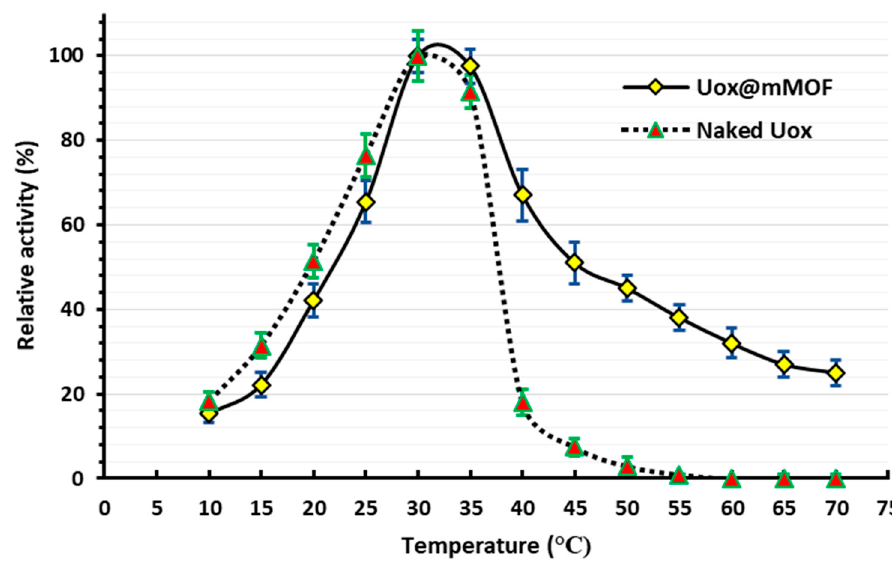
Figure 6. The optimum temperature of both Uox and Uox@NimMOF.